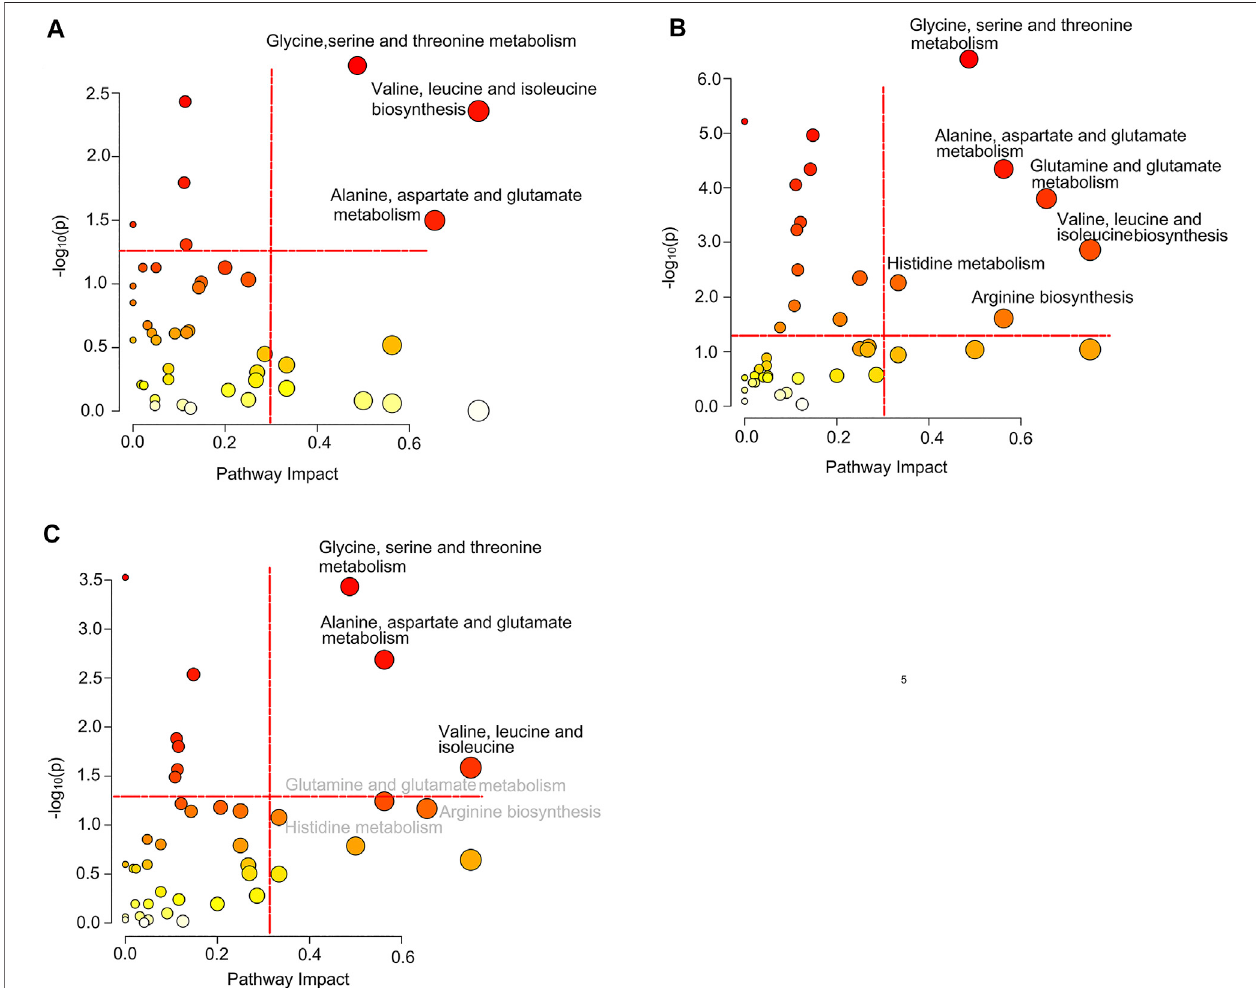
FIGURE5| Signi fi cantlydisturbedmetabolicpathwayscalculatedinthecomparison ofthreegroupsofTNBCpatients: (A) pSD patientsvs. pPRpatients; (B) pSD patients vs. pCR patients; (C) pPR patients vs. pCR patients.